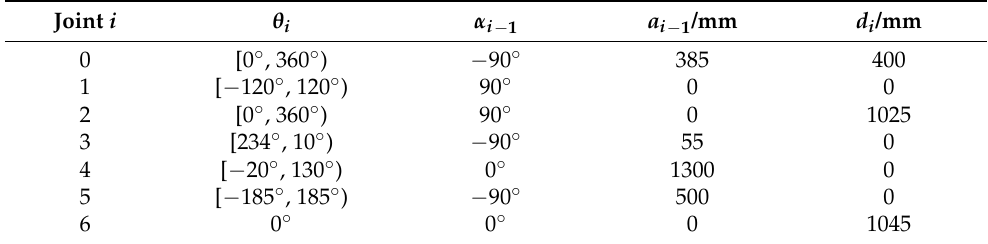
Table 1. The parameters of the KUKA KR500 robot.